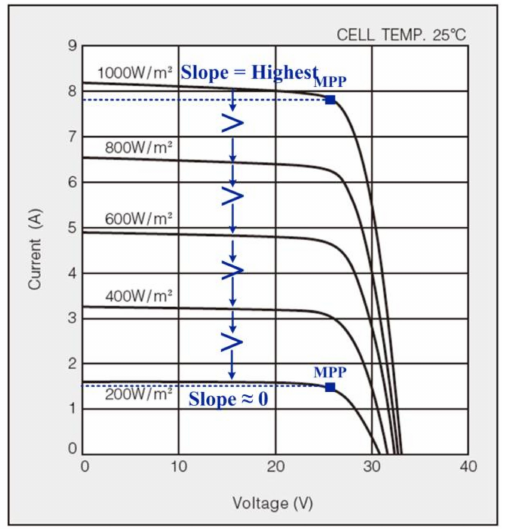
Figure 2. I-V curve of multi-crystalline PV module at distinct irradiance levels